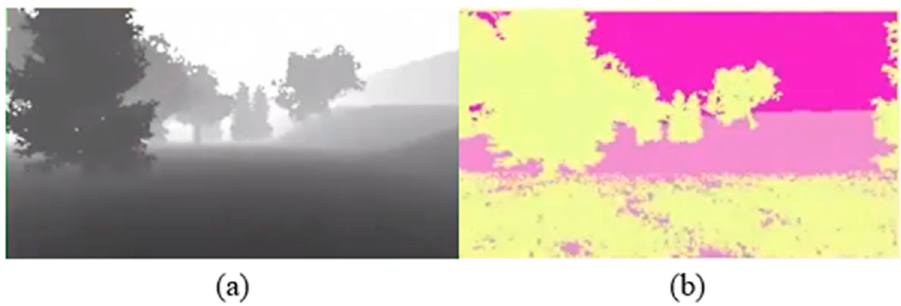
Figure 38. The depth image from Figure 37, ( a ) is the first-person-view depth image of the drone in Figure 37, ( b ) is the processed depth image.